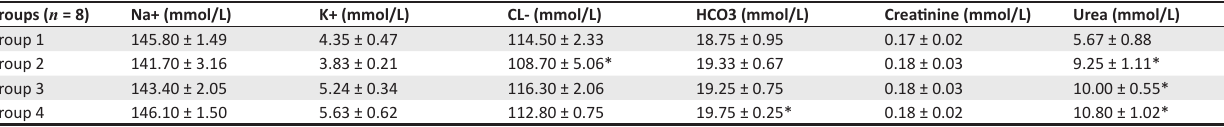
TABLE 3: Effect of calcium hypochlorite on serum electrolytes and metabolites. Groups ( n = 8)